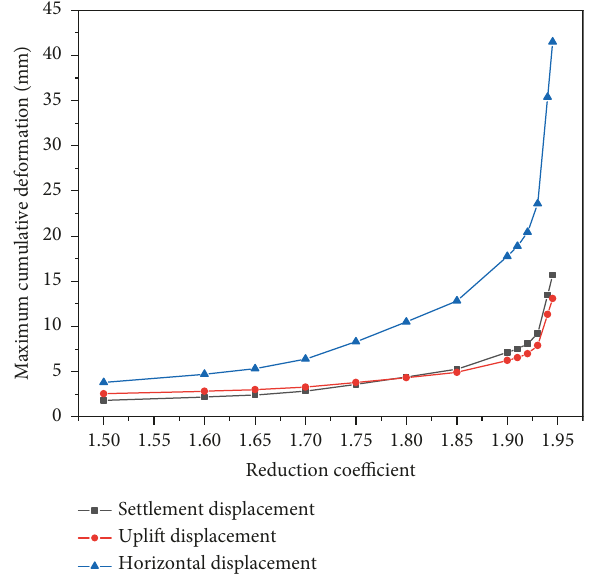
Figure 16: Variation law for displacement characteristic value of tunnel lining structure with Reduction